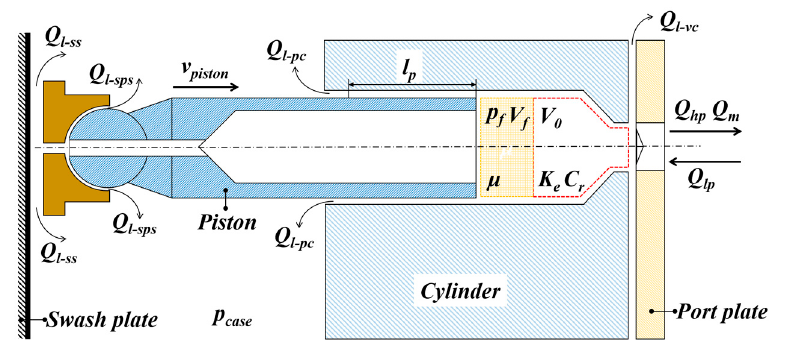
Figure 1. The configuration of the single piston model.